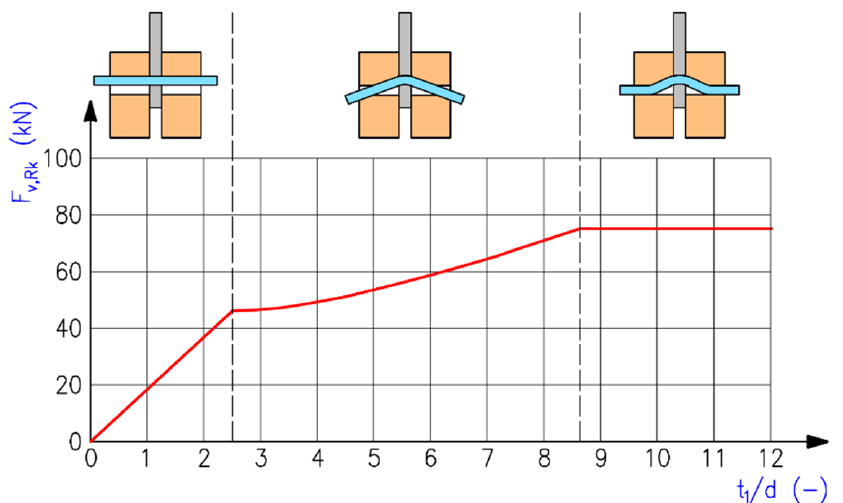
Figure 3. Influence of slenderness ratio t 1 /d on load-carrying capacity and failure mode of steel-to- timber double-shear connection with slotted-in steel plate (timber C24: ρ k = 350 kg/m 3 ; bolt M20 8.8: f u = 800 MPa; d = 20 mm; F ax,Rk = 0). For bolts, the characteristic value of the yield moment depends on the bolt diameter d and the characteristic tensile strength f u,k and is determined according to Formula (2). As can be seen from the units of relevant physical quantities, this formula was derived empirically from the research work of Blaß et al.